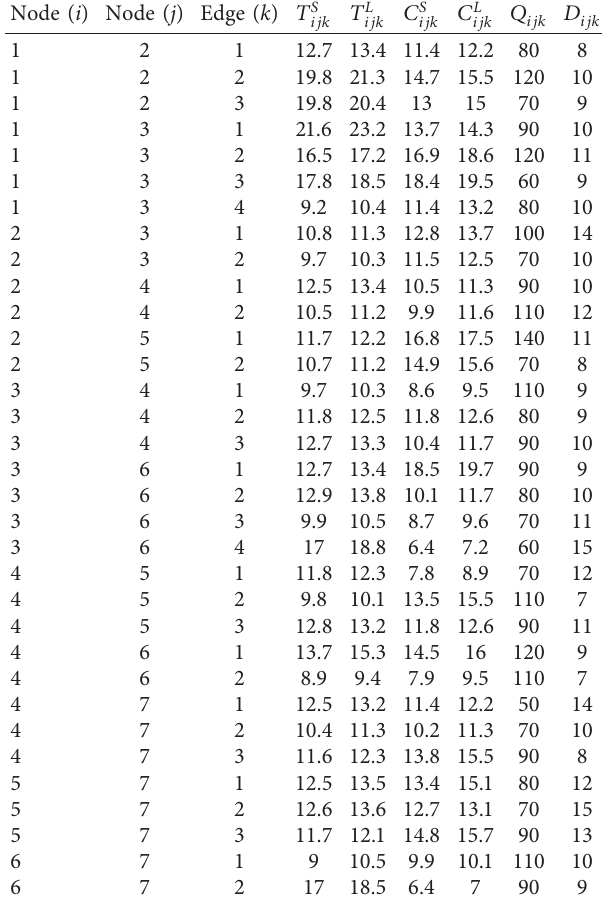
Table 4: Basic data of edges for example